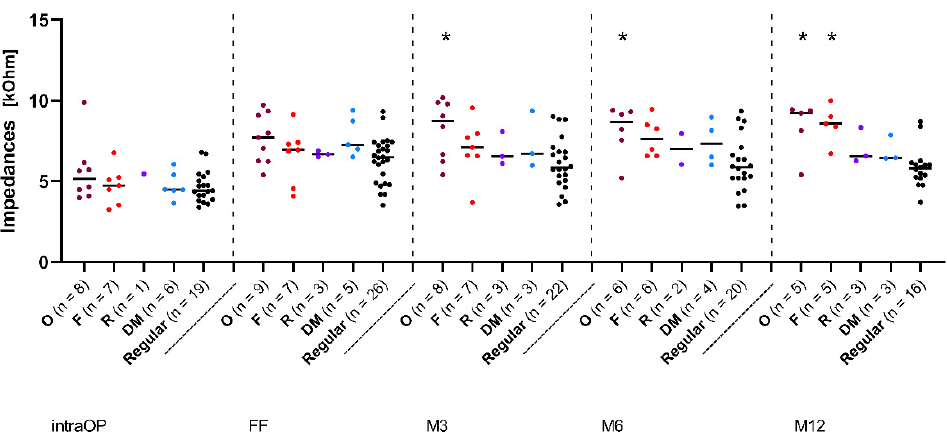
Figure 3. Change in impedances over time in subjects with different indications of IES use. Median overall electrode contacts C1–C12. The magenta dots represent patients with cochlear ossification (O), the red dots represent patients with fibrosis (F), the purple dots represent patients with occurring resistance (R), and the light blue dots represent patients for which the IES was used for cochlear depth measurement (DM). The black dots represent patients from the REGULAR group. Asterisks mark significant differences between groups.